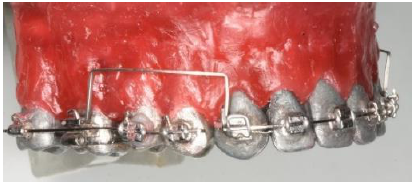
Figure 7. Cantilevers (UA6) applied on the typodont.